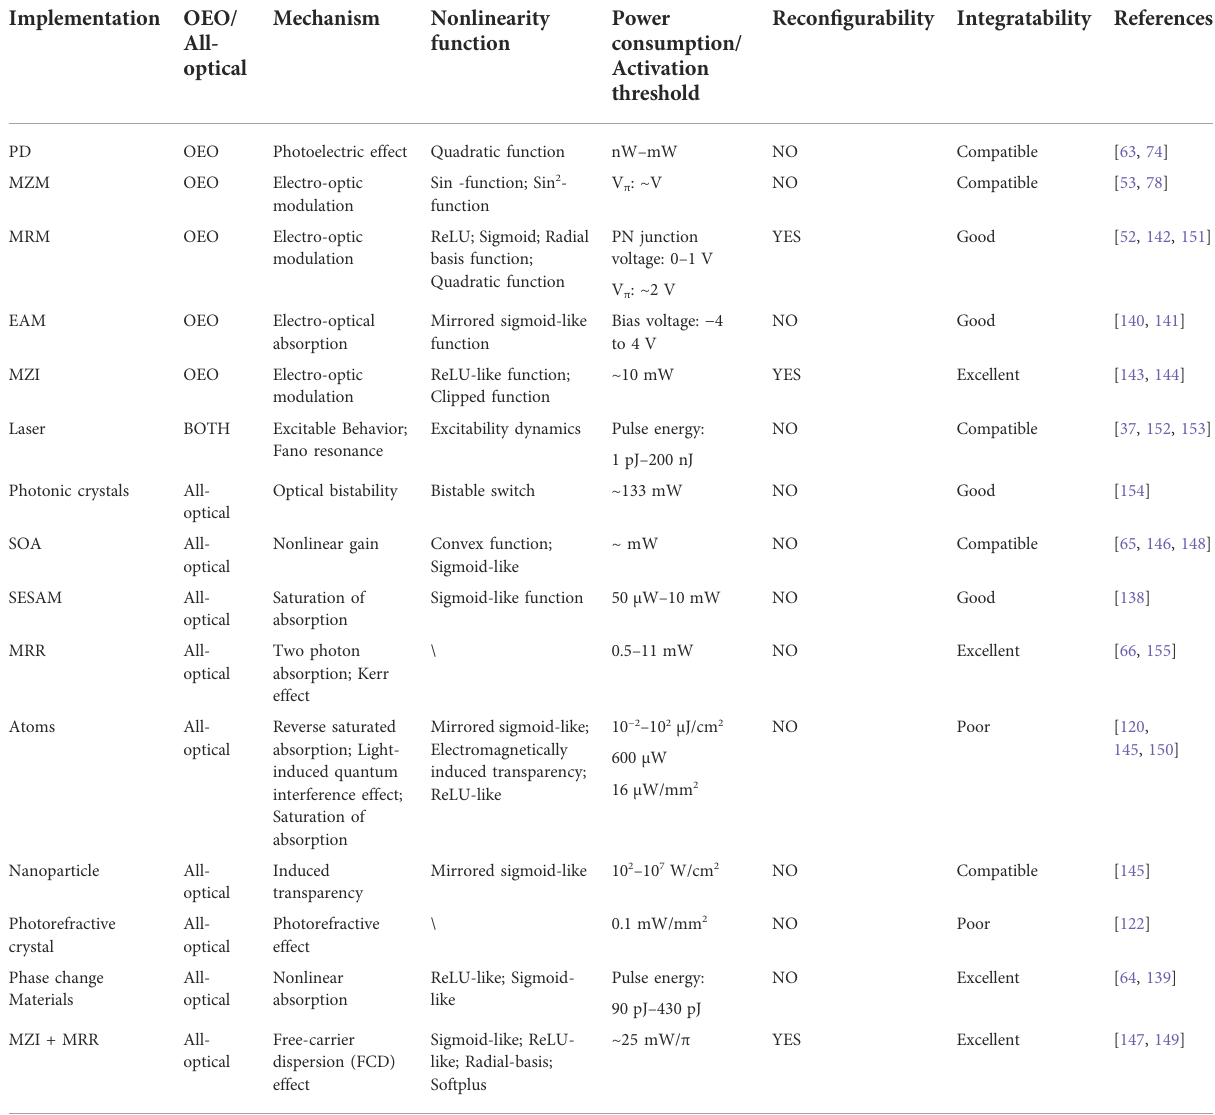
TABLE 1 The performance and characteristic for different optical nonlinearities. Implementation OEO/